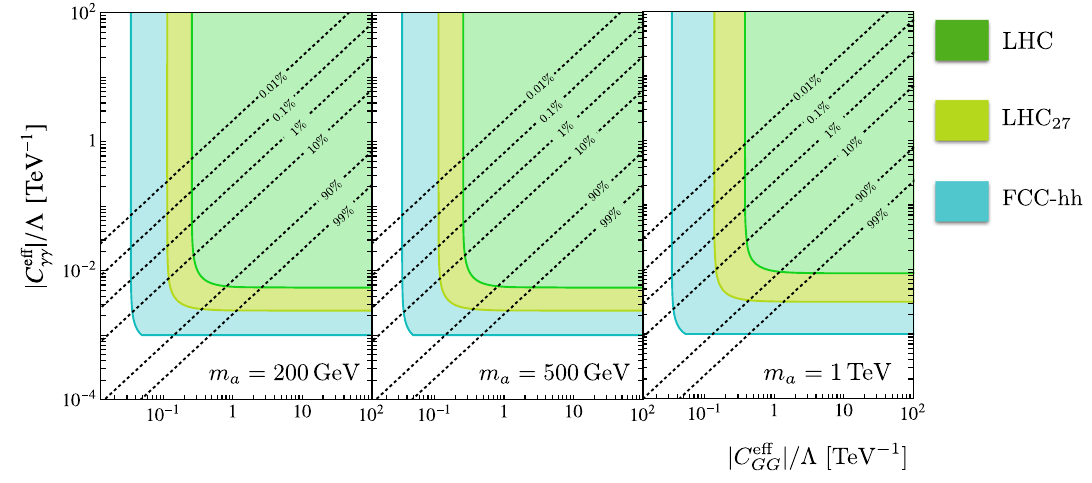
Fig. 13 Projected reach in searches for pp → a → γγ with the LHC (green), HE-LHC (light green) and a 100TeV collider (blue). Contours of constant branching ratios Br ( a → γγ) are shown as dotted lines. The sensitivity regions are based on 100 expected signal